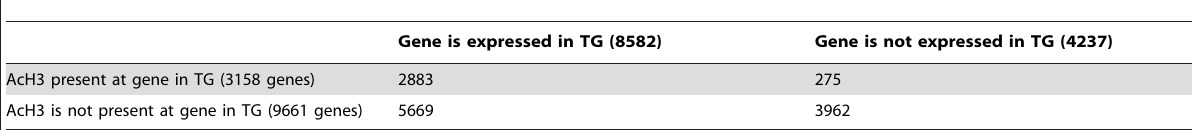
Table 4. Histone H3 acetylation and gene expression in TG striata.